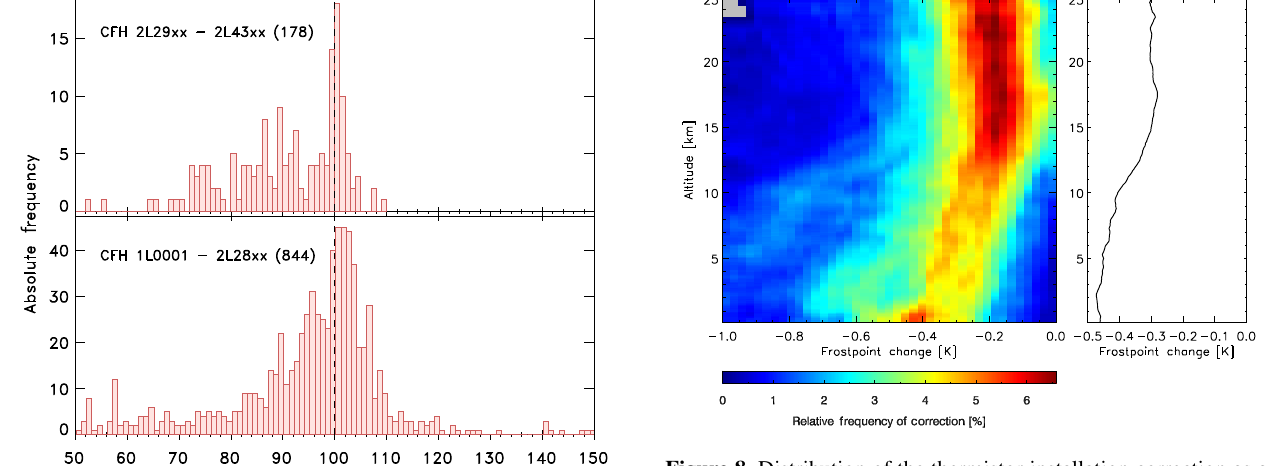
Figure 8. Distribution of the thermistor installation correction as a function of altitude for all soundings, where a bias is